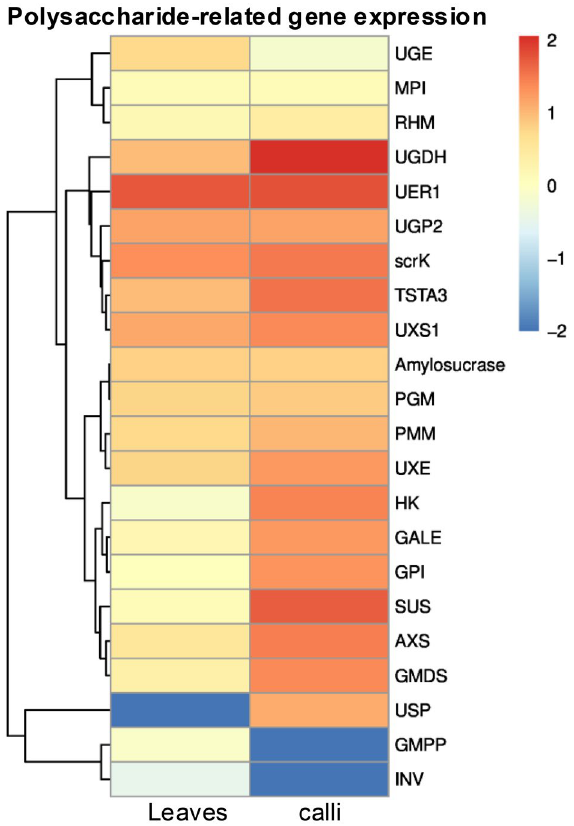
Figure 6. The expression levels of a single gene encoding an enzyme from each step of polysaccharides biosynthetic pathway in P . grandiflorus are shown. Red and green represent high and low expression levels,